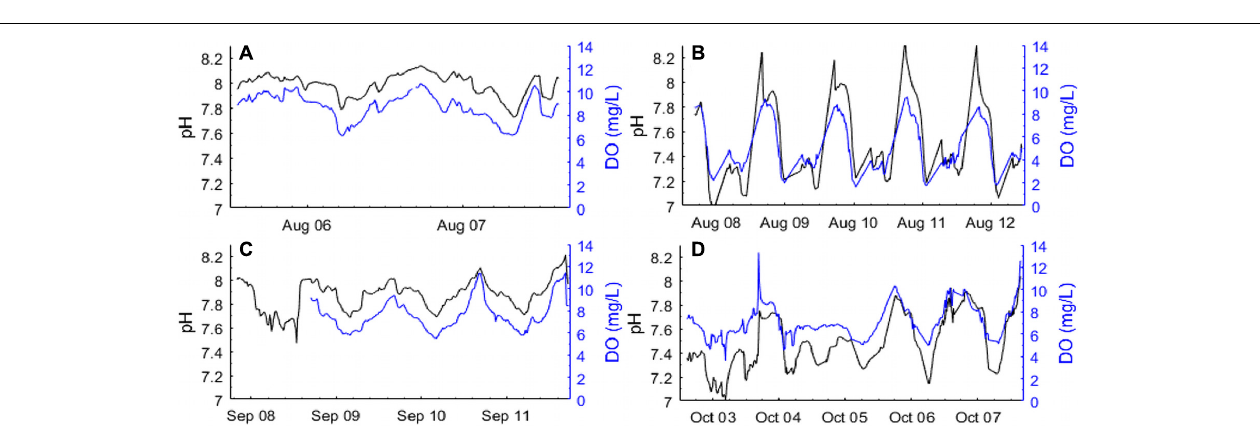
FIGURE 1 | (A) Map of Northeastern United States with (B) Long Island, (C) Shinnecock Bay, and Great Peconic Bay inset. Black shapes indicate sampling locations and shapes correspond to distinct habitats sampled.